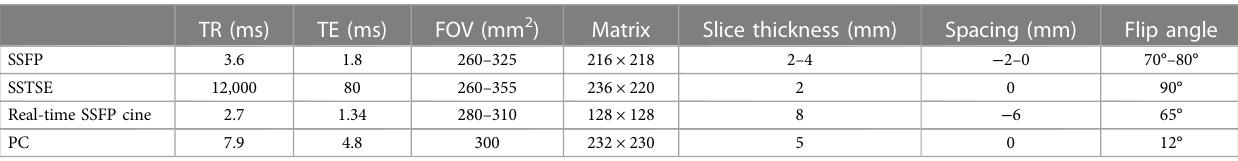
TABLE 1 Detailed parameters of fetal cardiovascular MRI sequences.